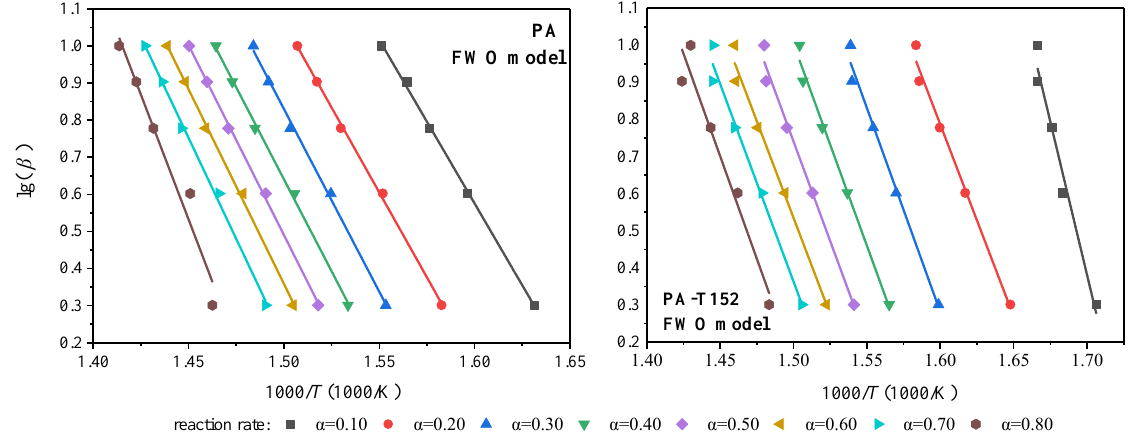
PA-T152 Vyazovkin model Figure 8. Calculation of E a from TG curves for PA and PA-T152 using Vyazovkin model. Table 3. Calorimetric data from dynamic scanning experiments of PA. Sample